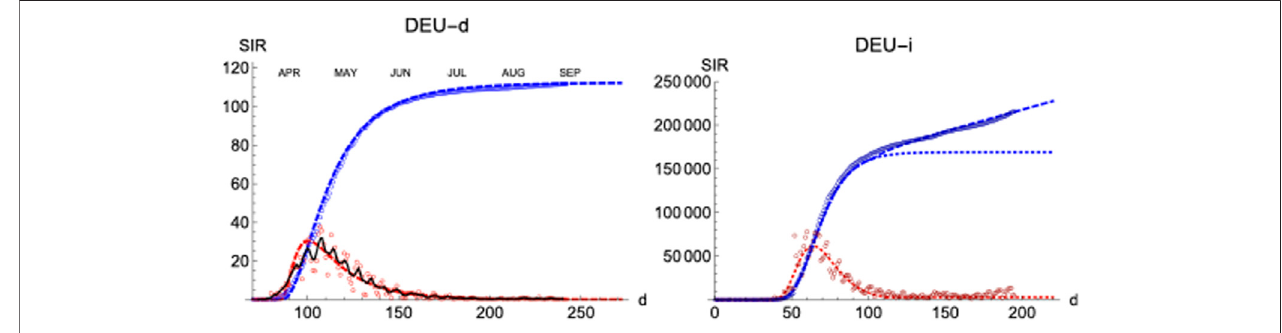
FIGURE 9 | SIR/Germany. Left/Right panels: Deaths/Infections. Blue: total cases, r ( t ) . Red: daily cases, i ( t ) ( × 10). Other symbols as in Figure 8 .